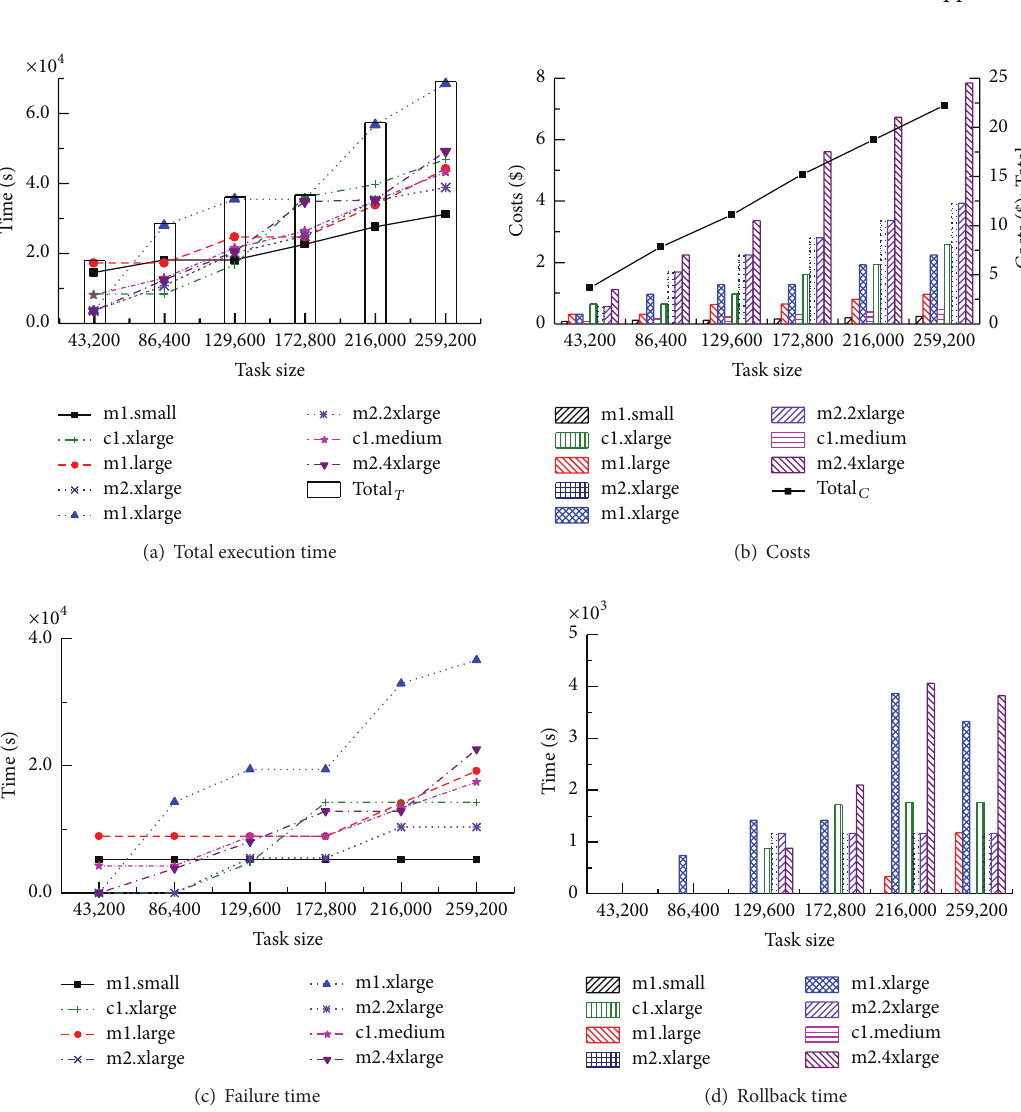
Figure 6: Simulation result in task